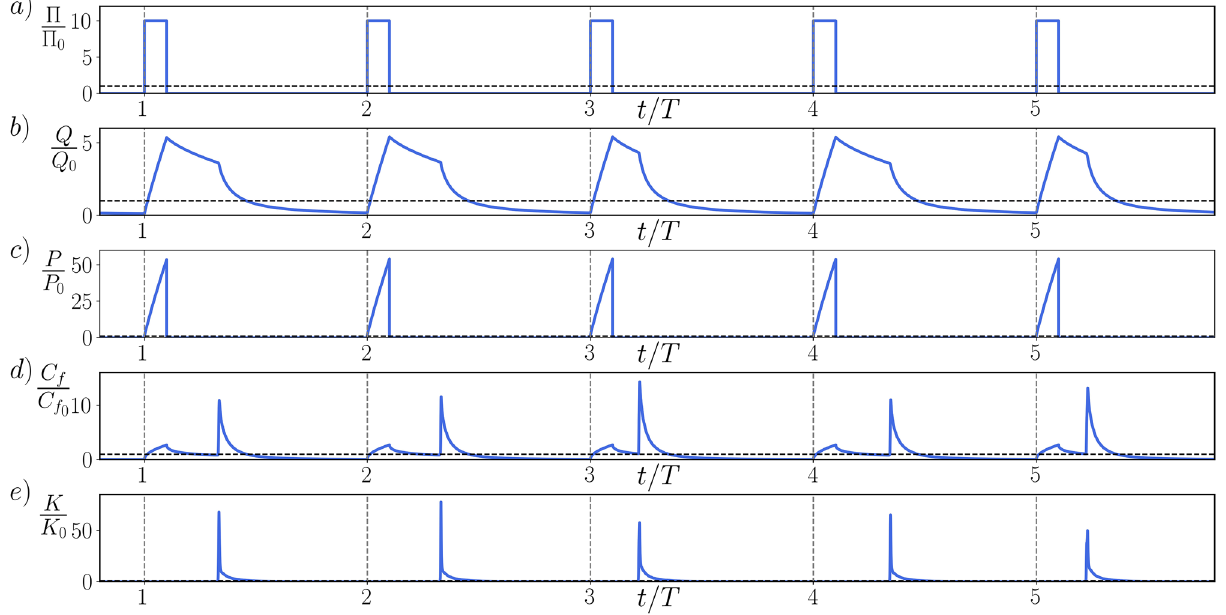
Figure 1. Time history of the flow performance: we report the evolution of ( a ) the pressure gradient (cid:31) , ( b ) the flow-rate Q , ( c ) the pumping power P , ( d ) the skin-friction coefficient C f and ( e ) the cross-stream turbulent kinetic energy K over five periods. Those are chosen from a simulation with parameters T = 1555 and ξ = 0.1 , which yield the maximum energy savings of our study. All quantities are referred to those of an uncontrolled turbulent channel flow at Re m 0 = 5626 . During the active pumping phase the flow-rate and the pumping power increase. After the pressure gradient is switched off (and the pumping power consequently becomes zero), the flow temporarily lingers in a quasi-laminar state, with high flow rate and low skin